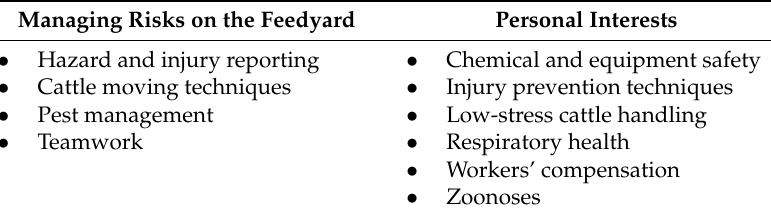
Table 2. Specific training topics of interest identified by